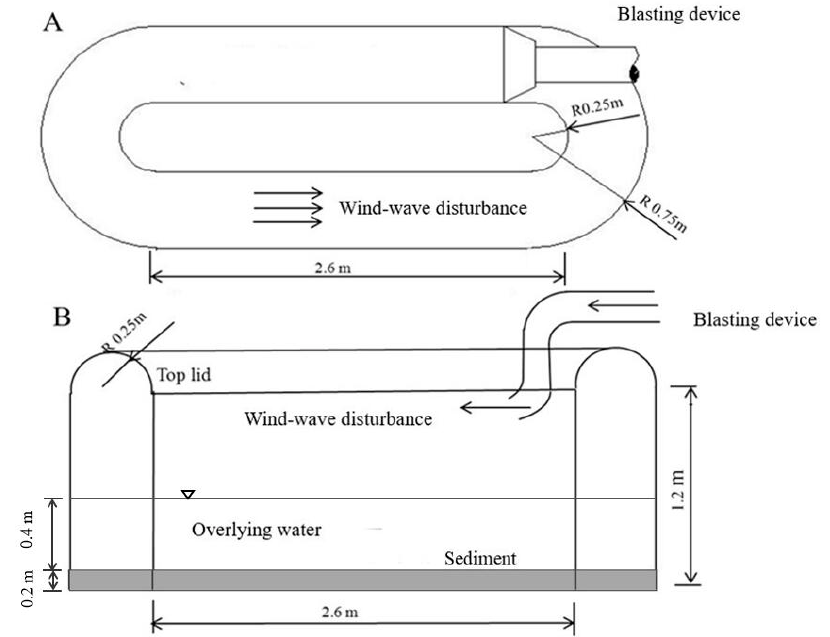
Figure 1. Schematic diagram of the annular flume. ( A ) is the planform of the flume, and ( B ) is the side view of the flume.